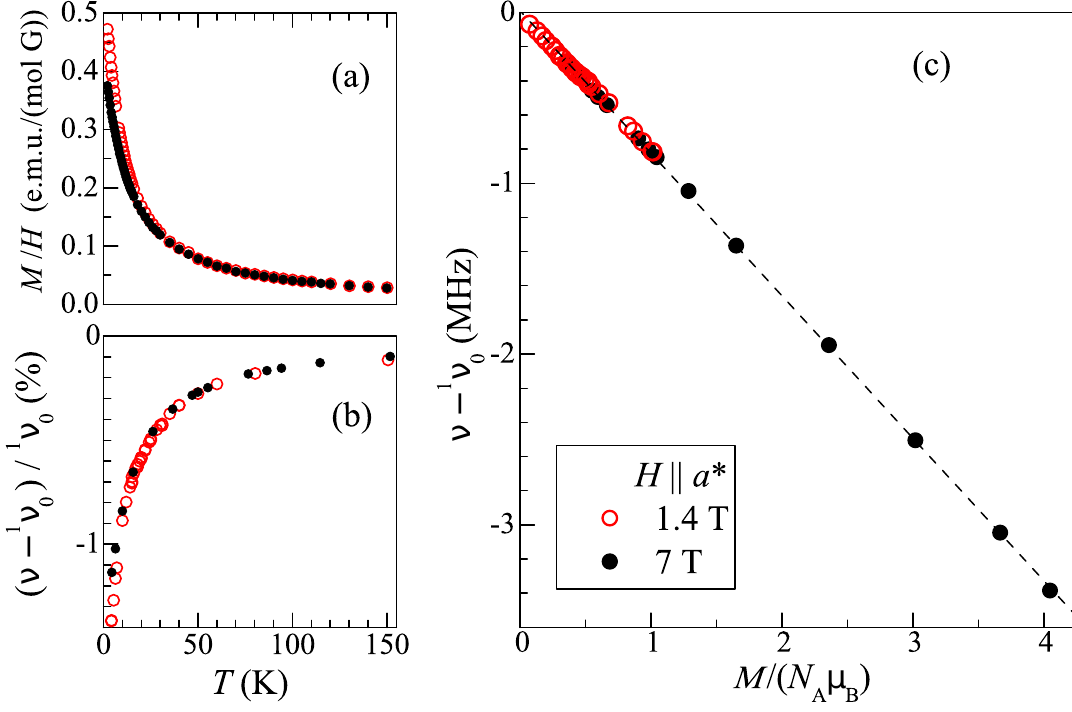
Figure 4. ( a ) Molar magnetization vs. temperature in H = 1.4 and 7 T; ( b ) Position of the lowest-frequency peak in 1 H NMR spectrum in ⃗ H ∥ ⃗a ∗ geometry vs. temperature in H = 1.4 and 7 T; ( c ) Position of the peak for the temperature range 4–150 K, in function of the DC = M/N magnetization per Mn ion, µ , measured at the same temperatures and fields A Mn and expressed in terms of the Bohr magneton, µ . Open red circles and closed black circles B correspond to the fields 1.4 and 7 T,